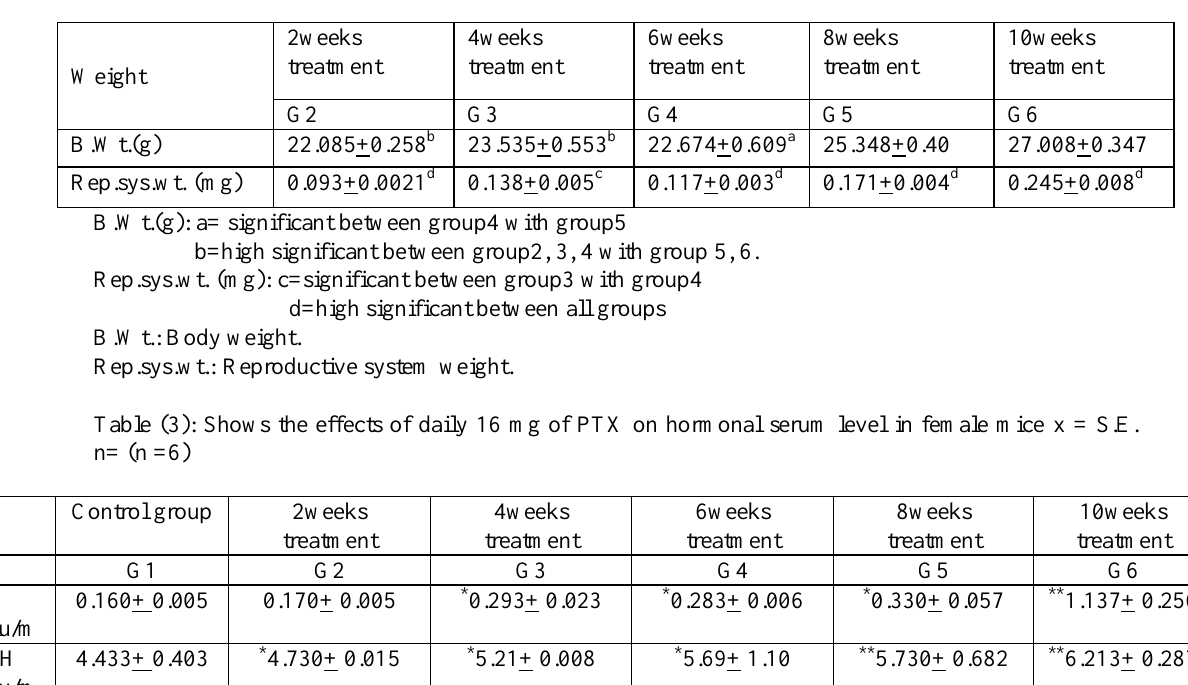
Table (2): Changes in the body weight and reproductive system weight after oral administration of 16 mg/ daily of Pentoxifylline to mature female mice. (Between groups) x = S.E. n= (n =10)